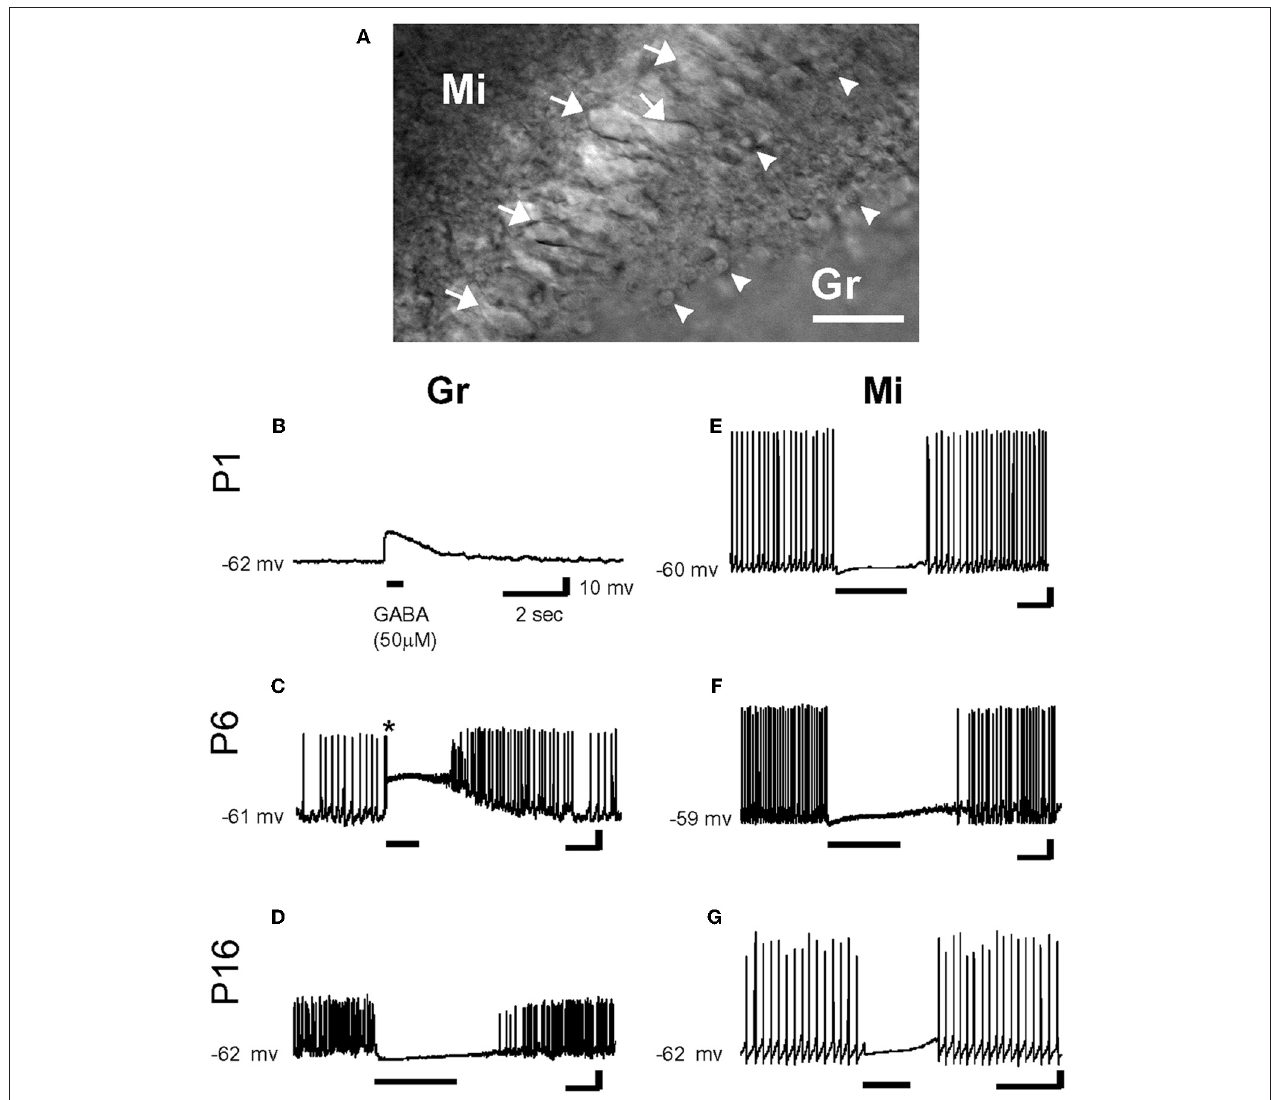
FIGURE 3 | Effects of γ -aminobutyric acid (GABA) in the developing rat olfactory bulb neurons. (A) IR-DIC images of granule cells (Gr: arrow head) and mitral cells (Mi: arrow) at P16. Thus, olfactory bulb neurons were distinguished by their location and morphology. Scale bar: 50 μ m. (B–G) By gramicidin-perforated patch-clamp recordings in the current-clamp mode,